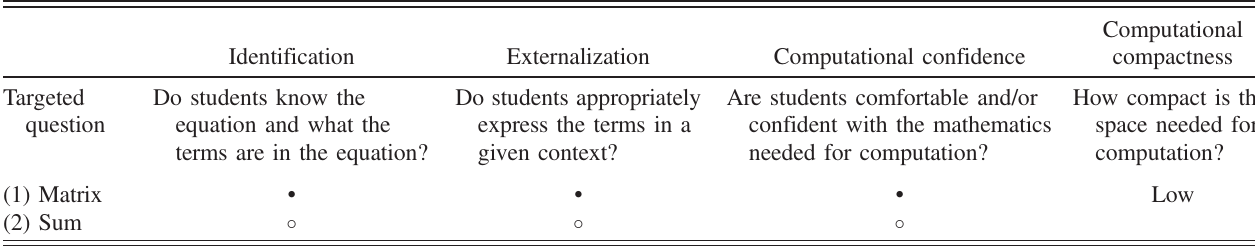
TABLE II. Example of data analysis for Raife ’ s calculation of h S y i .